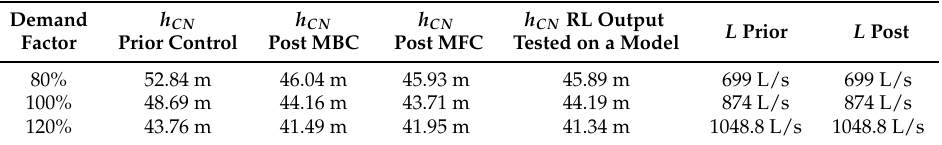
Table 1. Pressure observed on the critical node at 80%, 100% and 120% demand.